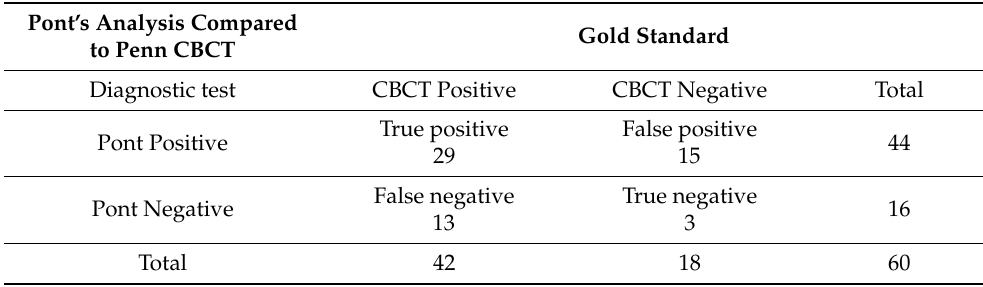
Table 2. Test results of Pont’s analysis compared to the reference standard Penn CBCT.